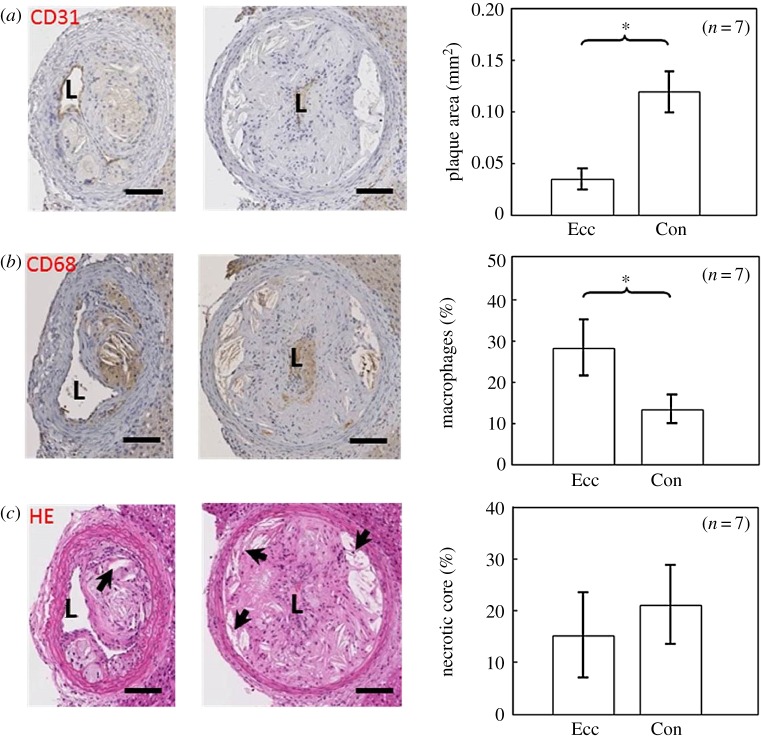
Characterization of plaque composition. Representative histological staining of the eccentric and concentric segment of representative mouse 1 and quantification of all mice is shown. (a) Plaque area (mm2) was delineated by CD31 endothelial staining; (b) relative macrophage area (%) was determined using CD68 staining; (c) relative necrotic core area (%) was delineated by H&E nuclei staining (arrows, necrotic cores); plaque area was significantly larger in the concentric segment, while macrophage area was larger in the eccentric segment (Student's t-test, n = 7, *p < 0.05). Scale bar is 100 µm.